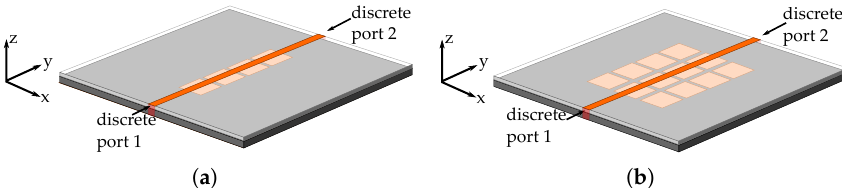
Figure 10. Suspended microstrip 3D design for simulations with different metasurface configurations; ( a ) 1 × 4 mushroom metasurface; ( b ) 3 × 4 mushroom